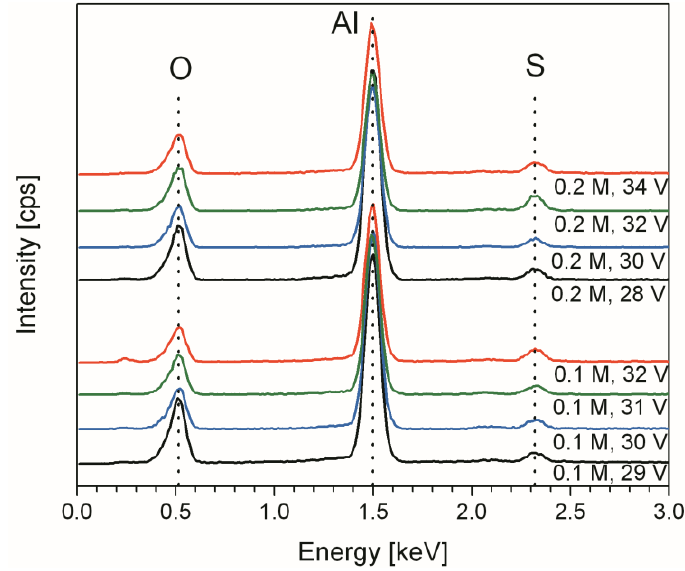
Figure 3. Comparison of energy-dispersive X-ray (EDX) elemental analysis of free-standing translu- cent PAA (obtained from 0.1 M H 2 SO 4 @ 29 V and from 0.2 M H 2 SO 4 @ 28 V) and opaque black (obtained at 30–34 V from both used electrolytes) b-PAA